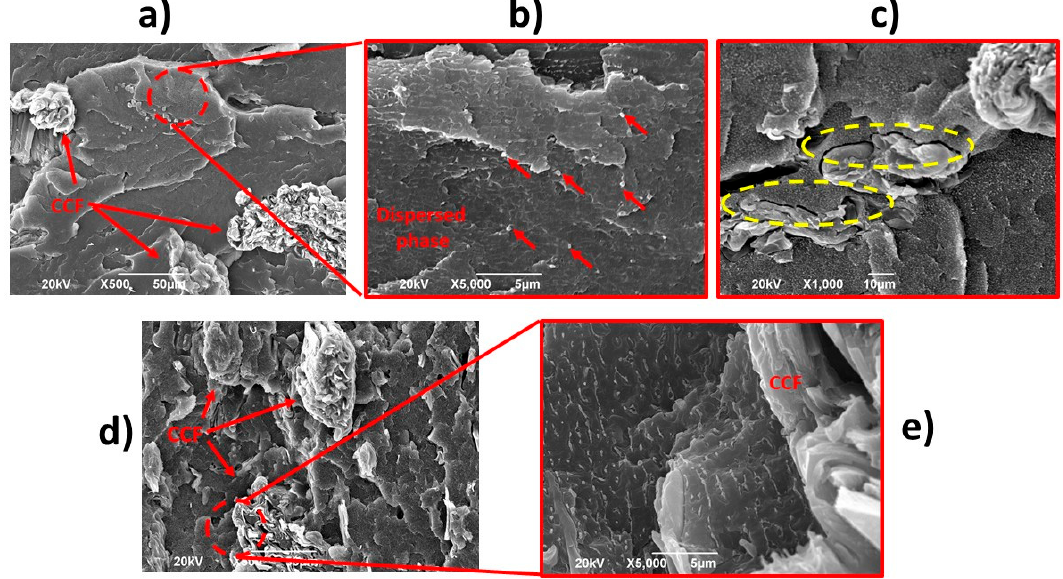
Figure 13. SEM micrographs for ( a ) PP, ( b ) HDPE and PP-HDPE blend ( c , d ).